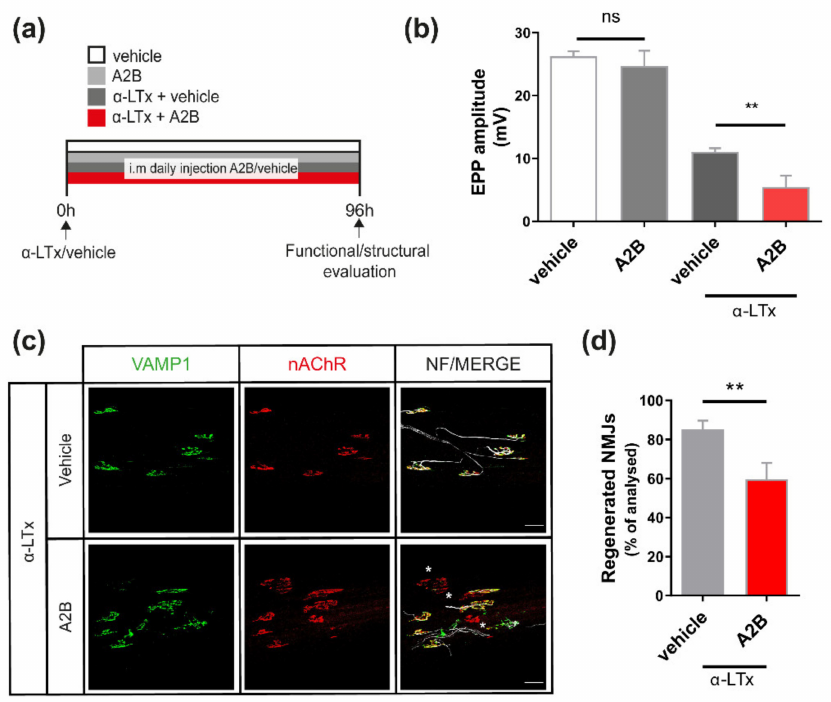
Figure 2. The CRHR2 receptor participates in the structural and functional recovery of the NMJ. ( a ) Scheme illustrating the treatment protocol, consisting of daily i.m. injections of either vehicle or the CRHR2 antagonist A2B up to 96 h after α -LTx injection, and the analysis performed to assess the functional and structural status of the NMJ. ( b ) Electrophysiological recordings of evoked EPPs from intoxicated soleus muscles after either vehicle of A2B administration. Each bar represents mean ± SD. n = 4 animals, 11 fibres. ** p < 0.01, ns p > 0.05. ANOVA followed by post hoc Tukey test. ( c ) Repre- sentative immunostaining and ( d ) quantification performed on soleus muscles after intoxication with α -LTx and treatment with either vehicle or A2B. Regenerated NMJs display both pre- and post-synaptic markers (VAMP-1 in green and nAChR in red, respectively). White asterisks indicate still degenerated NMJs (lack or little VAMP-1 signal). The right panel shows a magnification. Scale bars: 50 µ m. Bars in ( d ) represent the mean ± SD percentage of regenerated NMJs. ** p < 0.01 by Student’s t